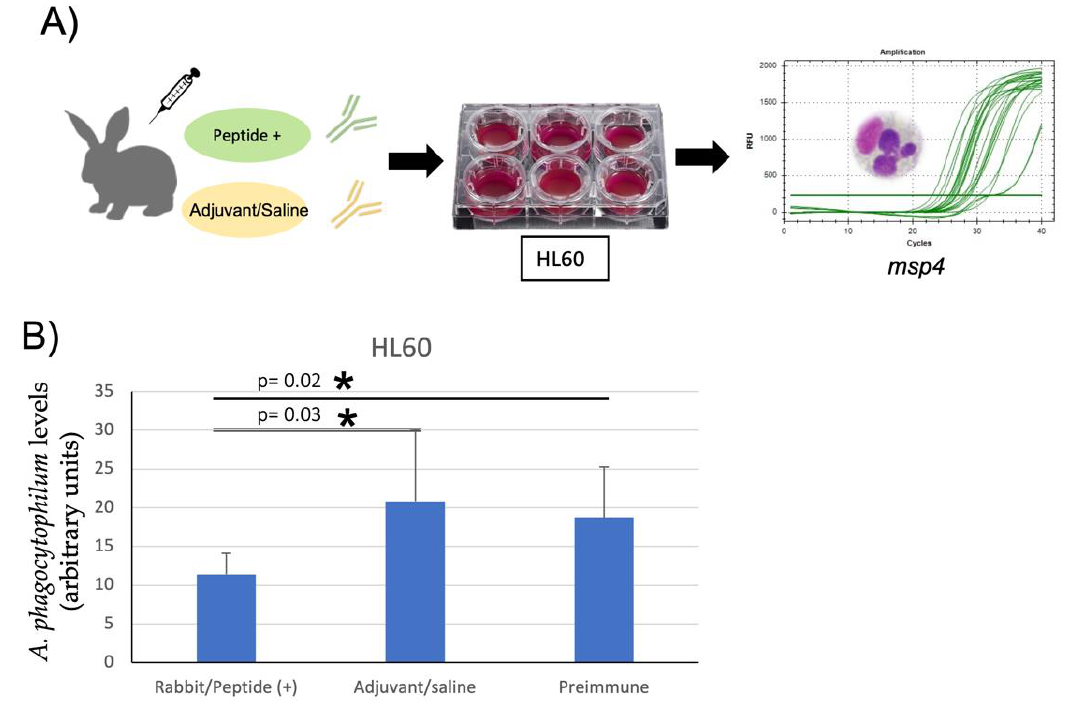
Figure 5. Experimental design of antibody inhibition assay in rabbits. ( A ) The IgGs from rabbits immunized with peptide+ and adjuvant/PBS alone were used to assess the efficacy of the protective response to A. phagocytophilum by inhibition assay in human HL60 cells in the conditions mentioned in the previous assay; ( B ) normalized msp4 levels in treated HL60 cells; antibody inhibition assay using IgGs from rabbits immunized with peptide + compared to rabbits immunized with adjuvant/saline and pre-immune sera. Results were analyzed using a Student’s t -test with unequal variance (* p < 0.05; n = 6 replicates per treatment). Asterisks denote statistically significant differences between groups. Relative infection levels were expressed in arbitrary units.